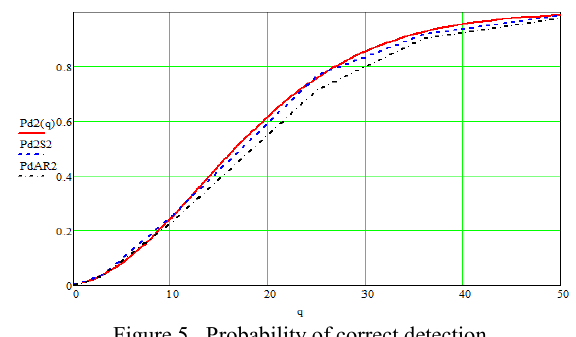
Figure 5. Probability of correct